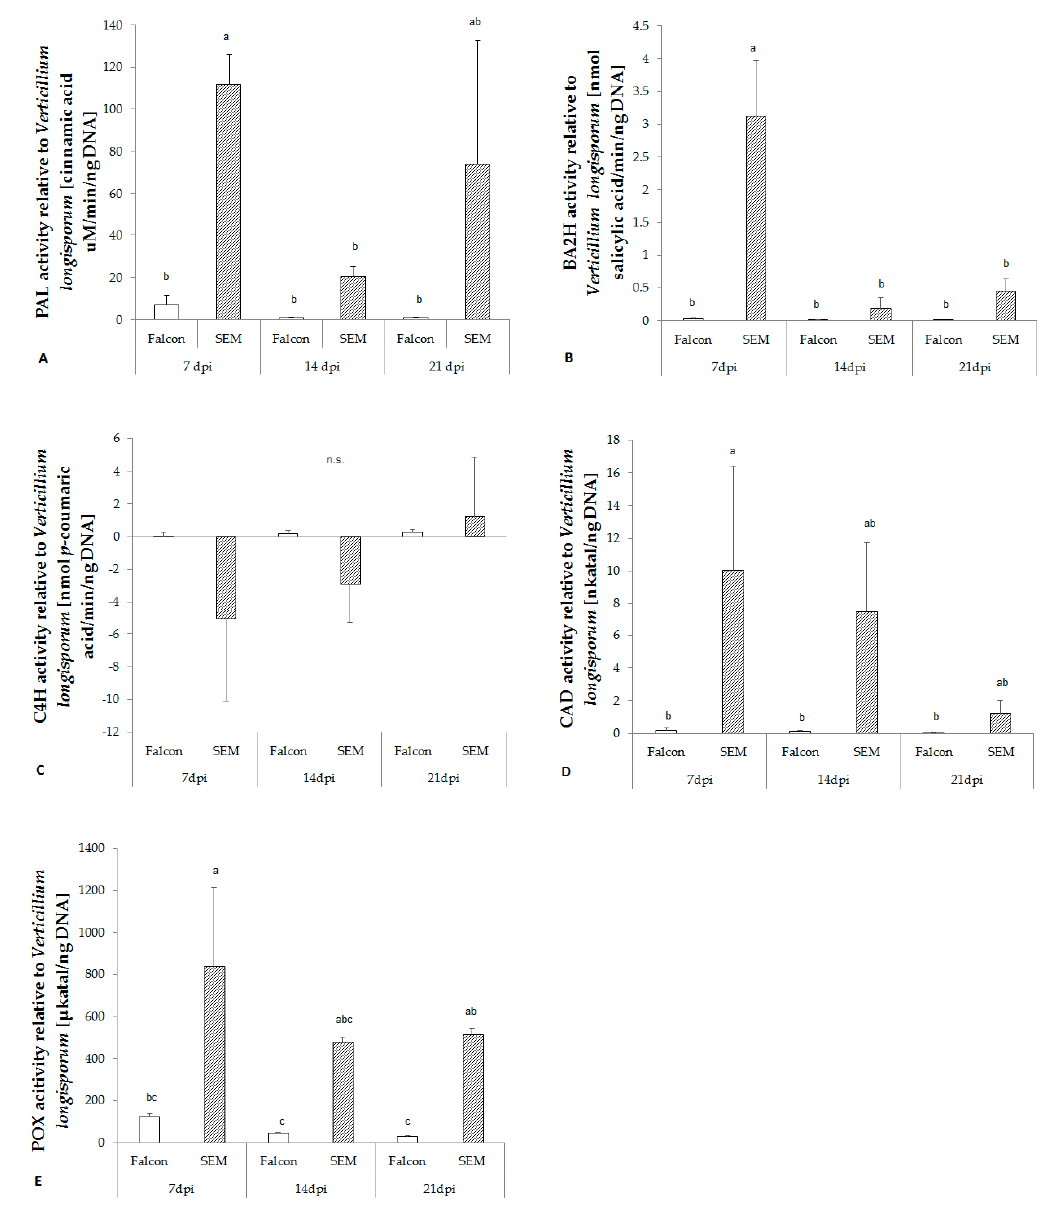
Figure 4. Enzyme activity in the hypocotyl of B. napus cv. Falcon and SEM inoculated with V. longisporum . ( A ) PAL, phenylalanine ammonia lyase; ( B ) BA2H, benzoic acid 2-hydroxylase; ( C ) C4H, cinnamate 4-hydroxylase; ( D ) CAD, cinnamyl alcohol dehydrogenase; ( E ) POX, peroxidase. Bars indicate standard errors. Different letters indicate significant differences among the treatments (LSD test, P < 0.05). n.s. means no significant difference.